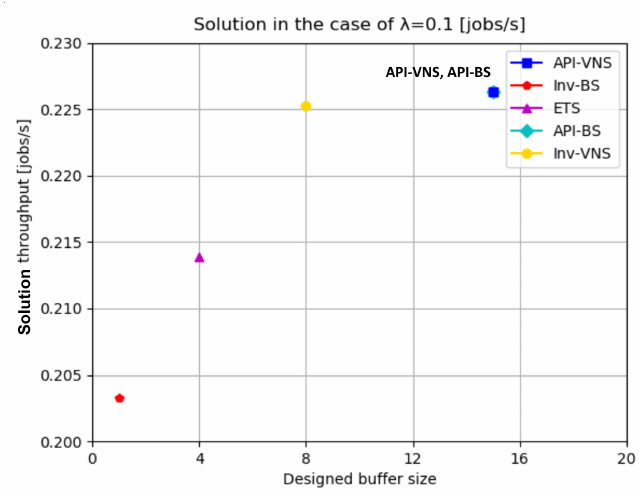
Figure 18. Scatter plot of designed bu ff er size vs. solution throughput for the five methods in the case of λ = 0.1 in experiment